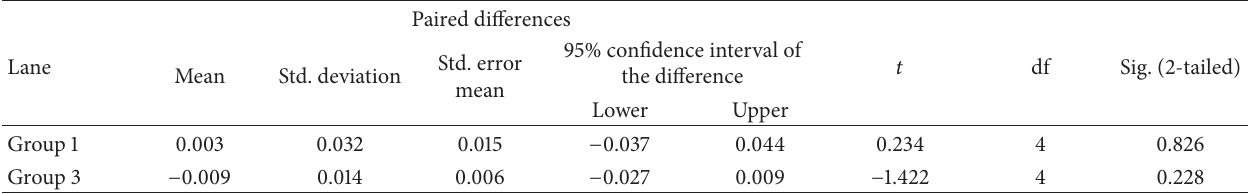
Table 14: Paired 𝑡 -test